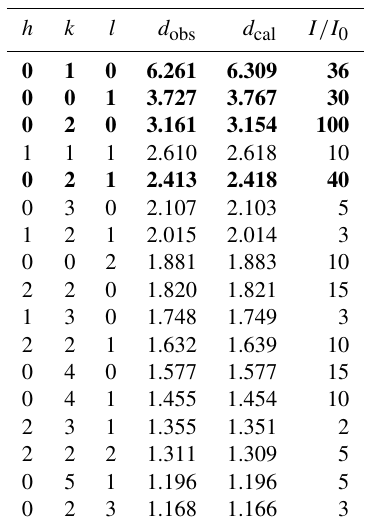
Figure 4. The IR spectrum of wumuite. Table 2. X-ray powder diffraction data ( d inÅ) for wumuite. The four strongest reflections are given in bold.